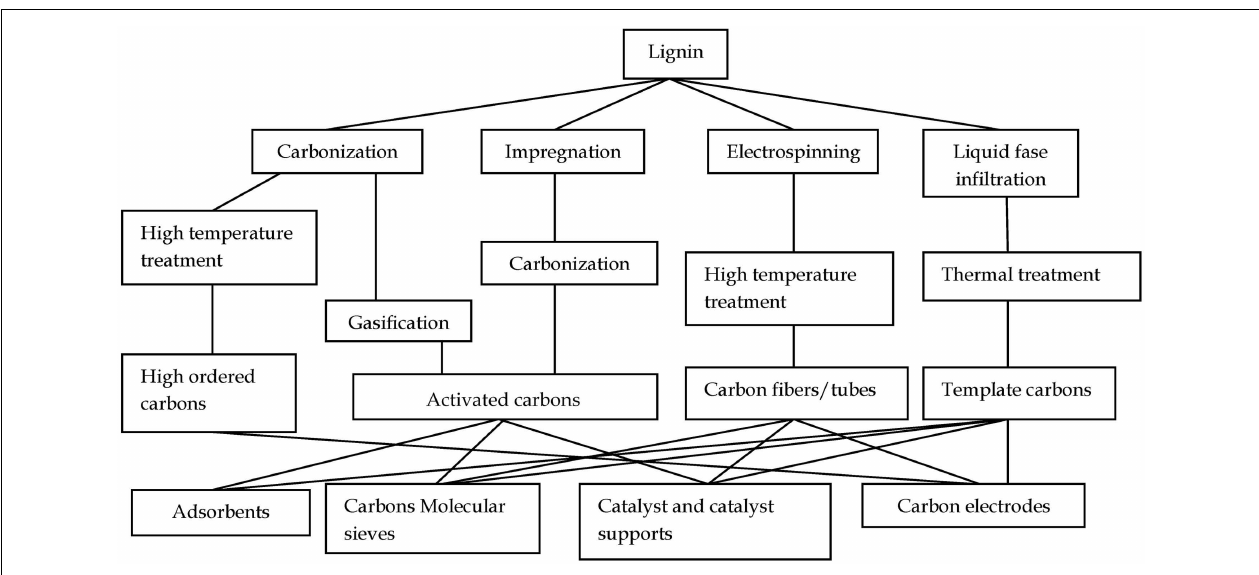
FIGURE 2 | Possible routes of lignin thermochemical conversion